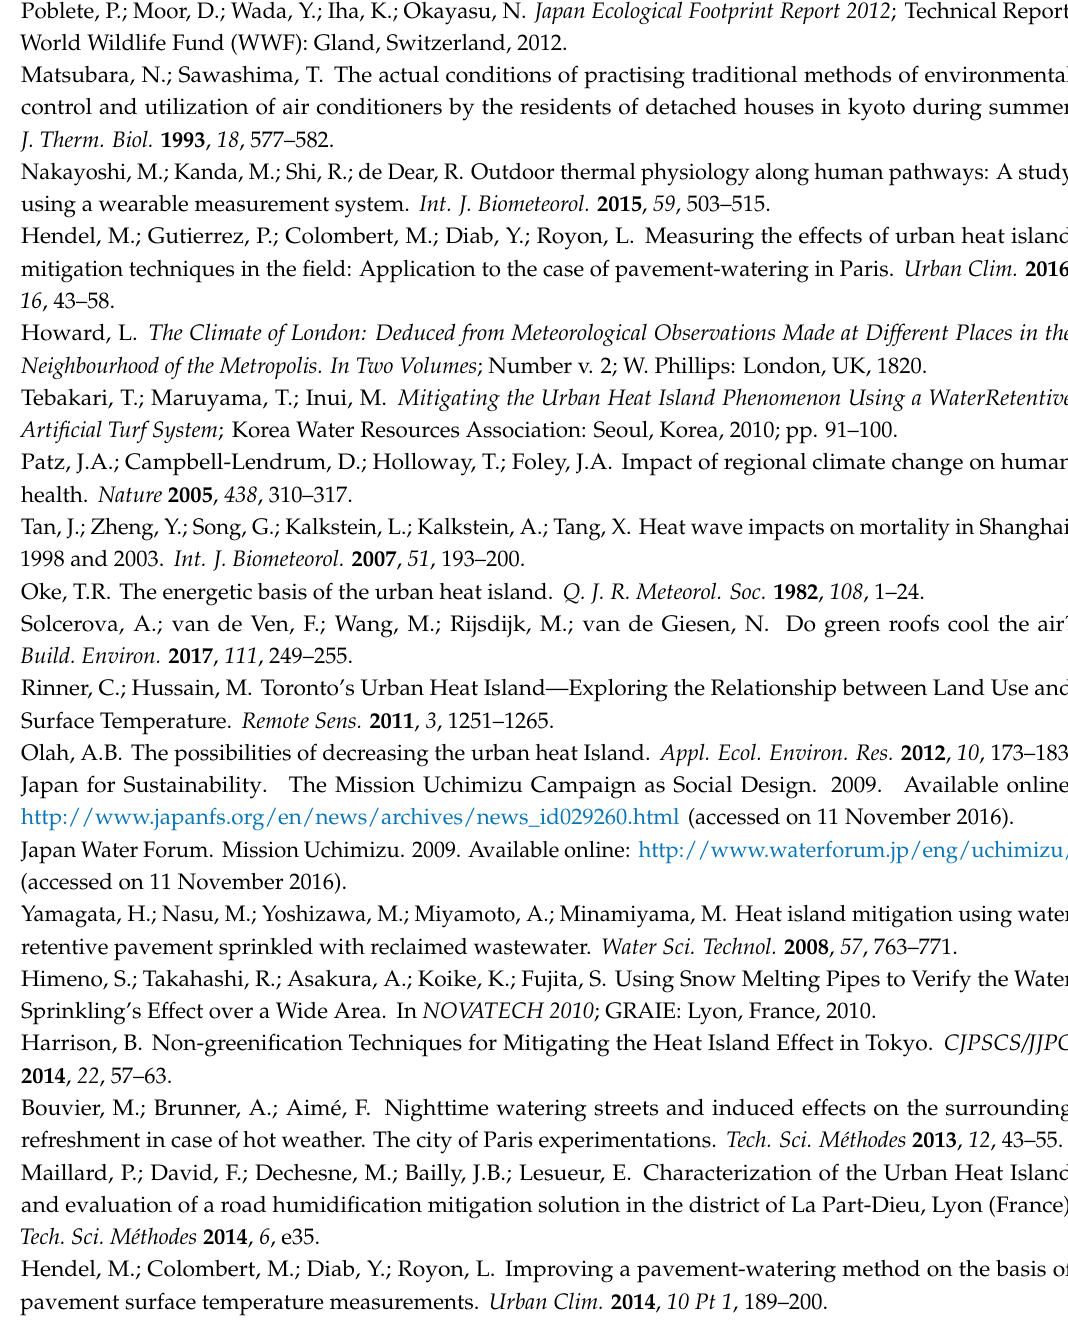
Table S1: Sensors used in the measurement campaign, their resolution and